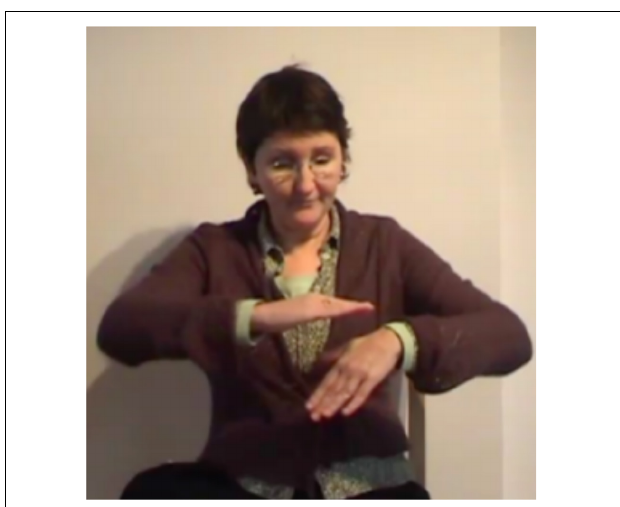
FIGURE 15 | Classifier construction that traces a flat surface in the reconstrual of a cliff.